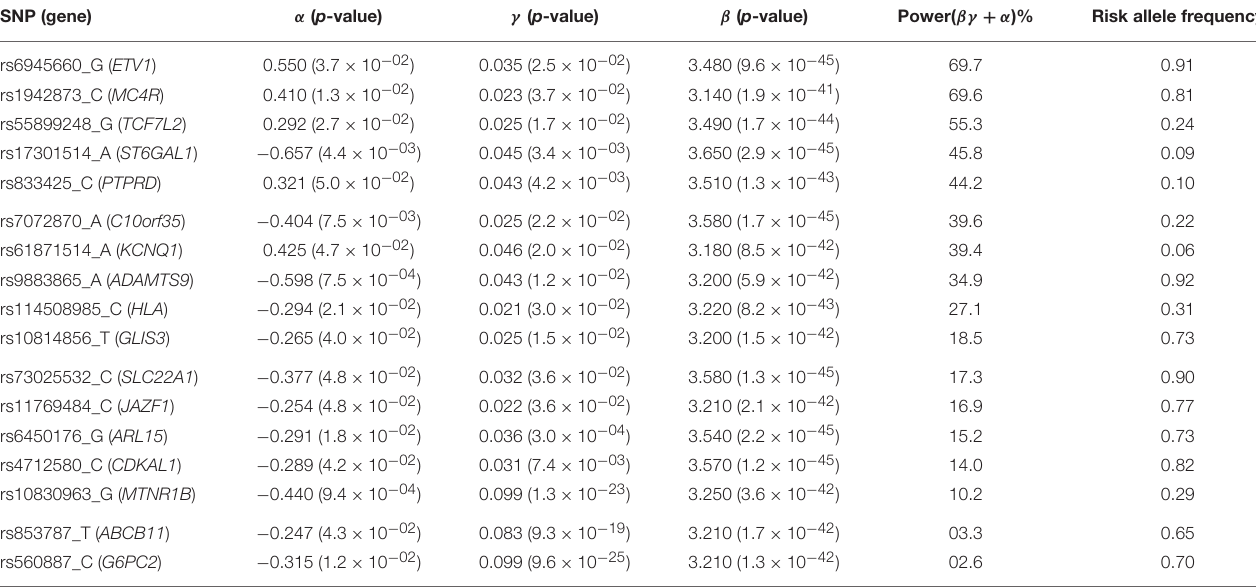
TABLE 3 | List of loci found to be associated within the joint modelling framework with both FPG and T2D risk, previously shown as associated with FPG and/or T2D risk in the NHGRI GWAS Catalogue ( Welter et al.,